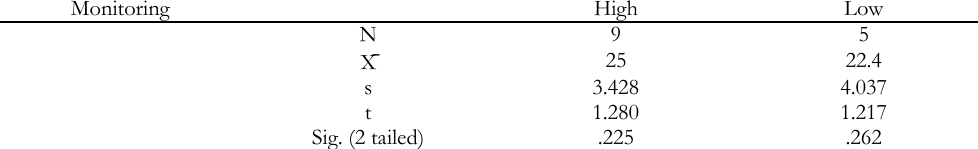
TABLE 2. Independent T-test for Monitoring Strategy on Metacognitive Writing Strategies